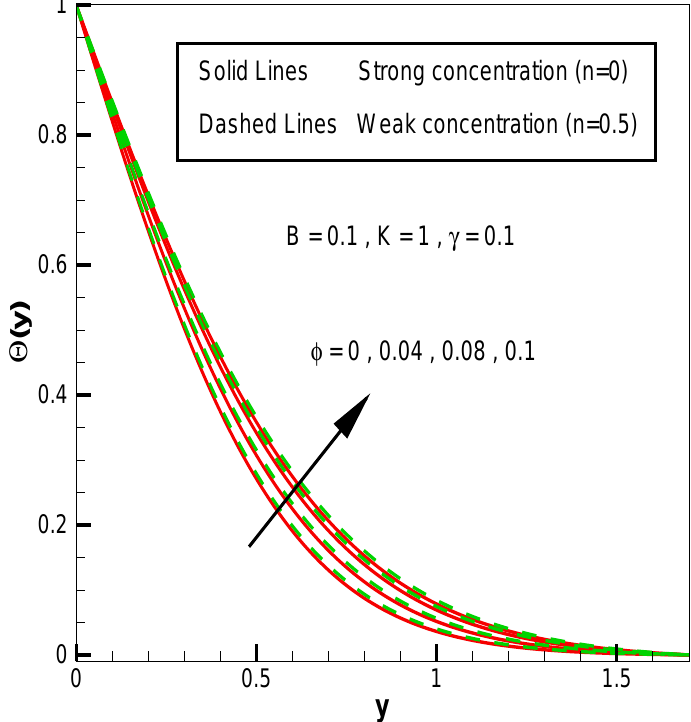
Figure 6. 𝛉(𝐲) for material parameter 𝐊 .